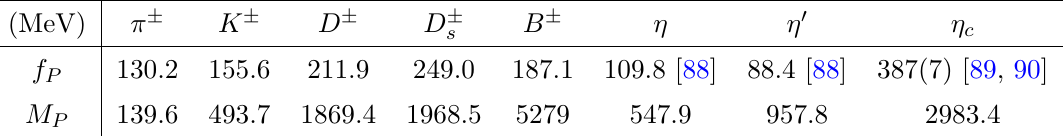
Table 6 . Decay constants and masses for pseudoscalar mesons: (cid:25) (cid:6) , K (cid:6) , D (cid:6) , D (cid:6) (cid:17) , (cid:17) 0 and (cid:17) c .